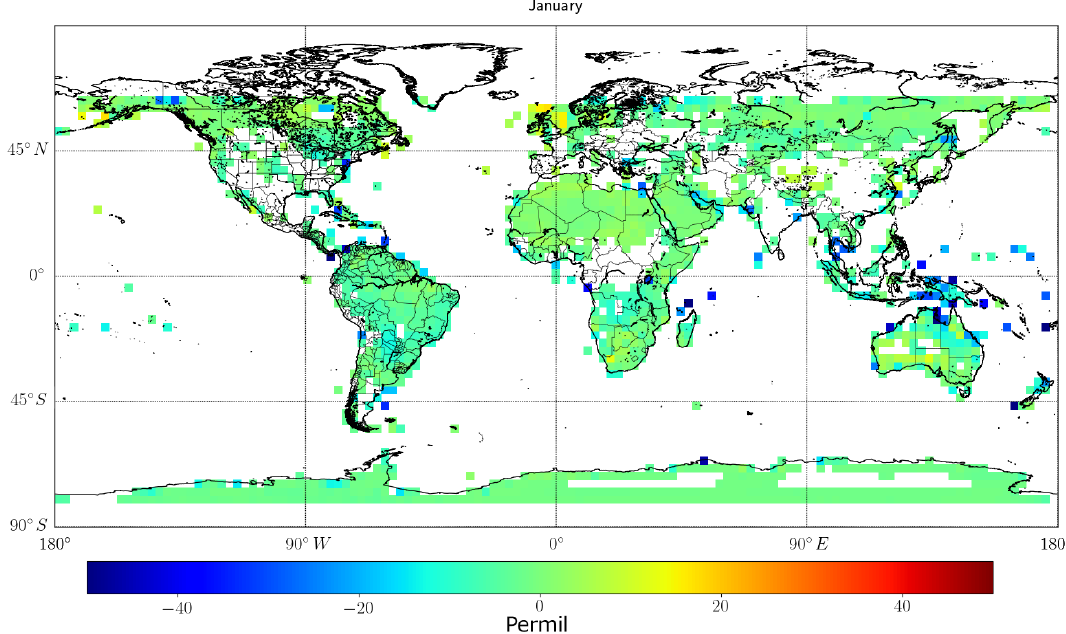
Figure 16. Difference in δ 13 C values from non-scattering retrievals and scattering retrievals without instrument noise. The figure represents a day in the month of January 2015 for SWIR1 retrievals.